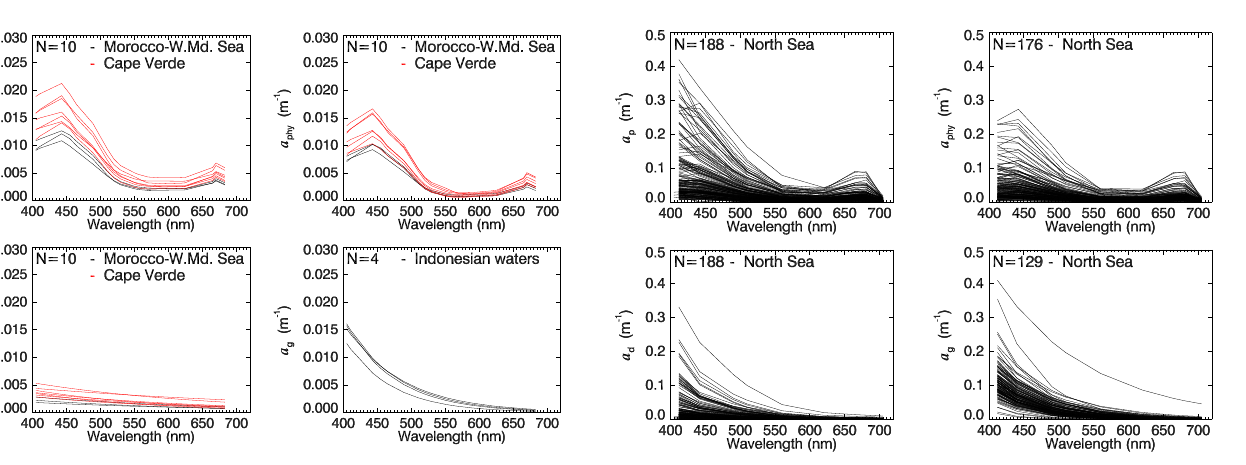
Figure 11. The match-up field absorption spectra provided from Morocco-W. Md. Sea, Cape Verde, and Indonesian waters.